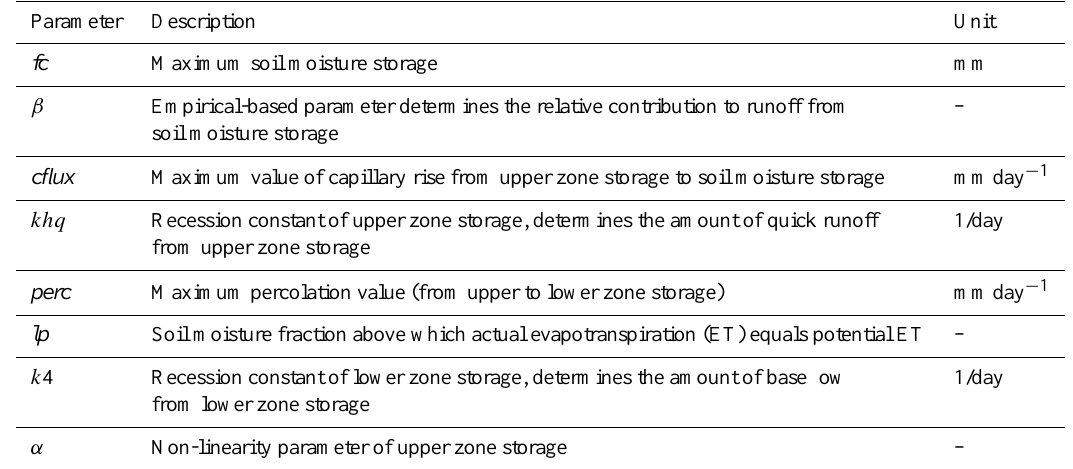
Table 1. Parameters of the soil moisture and runoff routines in the OpenStreams wflow_hbv model.